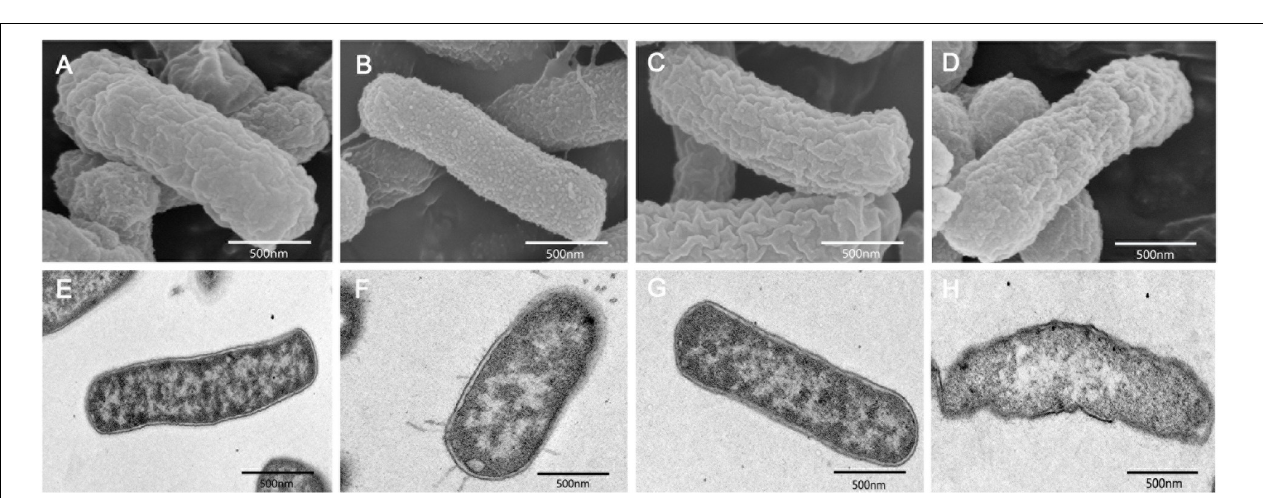
FIGURE 2 | Time-kill assays showing the effects of colistin or auranofin alone or in combination against high-level Col-R K. pneumoniae 18605 (A) , E. coli C1157 (B) , P. aeruginosa 26587 (C) , and A. baumannii 13660 (D) .